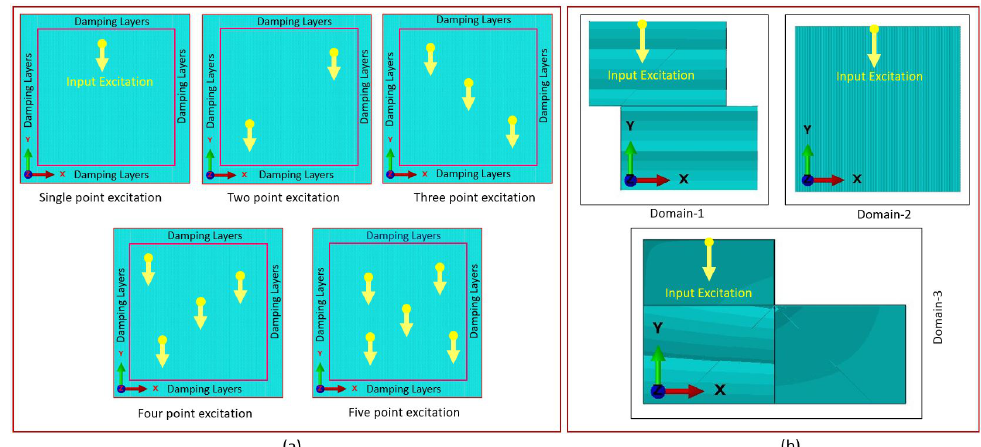
Figure 1. ( a ) Type-1 datasets: finite-element models: FE models with single to multi-point sources excitation are triggered in the Y-direction, and an absorbing boundary condition is applied on all the domain edges, to avoid undesired reflection. ( b ) Type-2 datasets: finite-element models: FE models with single-point source excitation are triggered in the Y-direction on the top edge of the model and a traction-free boundary condition is applied on all other